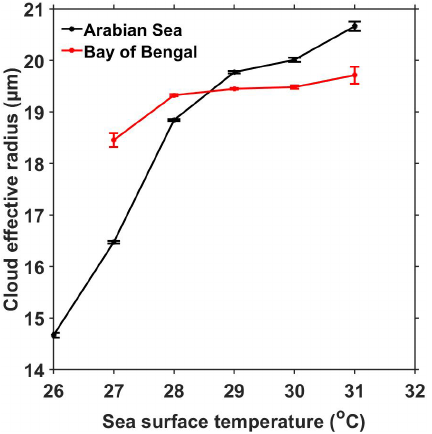
Figure 7. Variation in mean and standard error of CER liquid (in µm) with SST over the AS and the BOB during the ISM